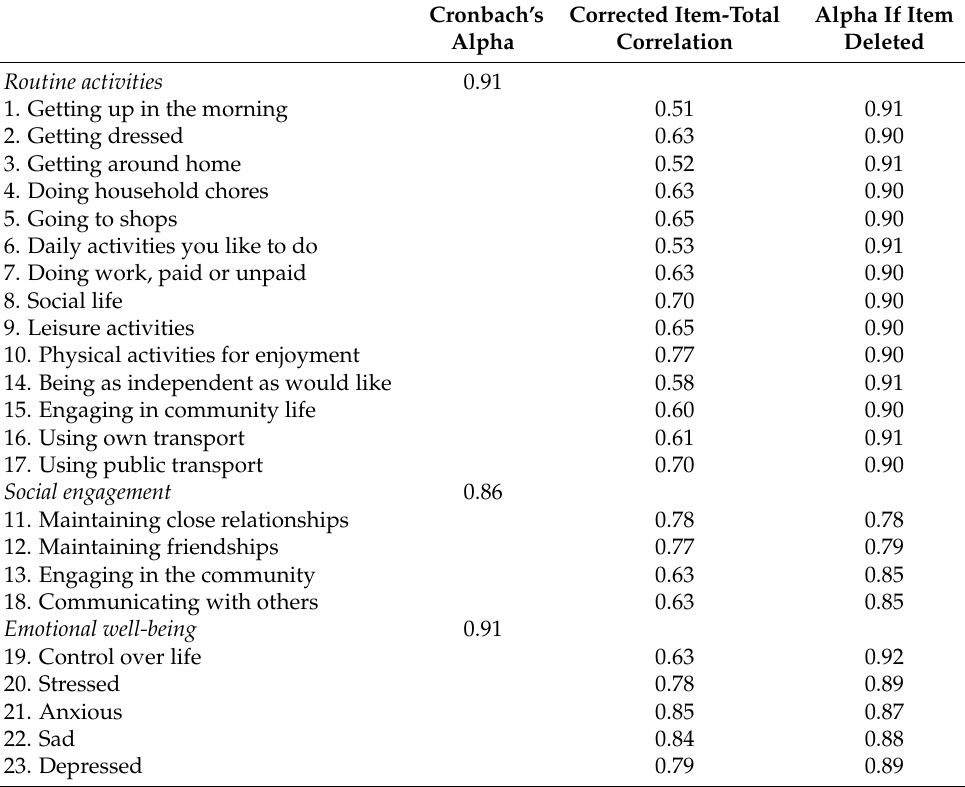
Table 2. Internal consistency of the Chinese version of the Oxford Participation and Activities Questionnaire.